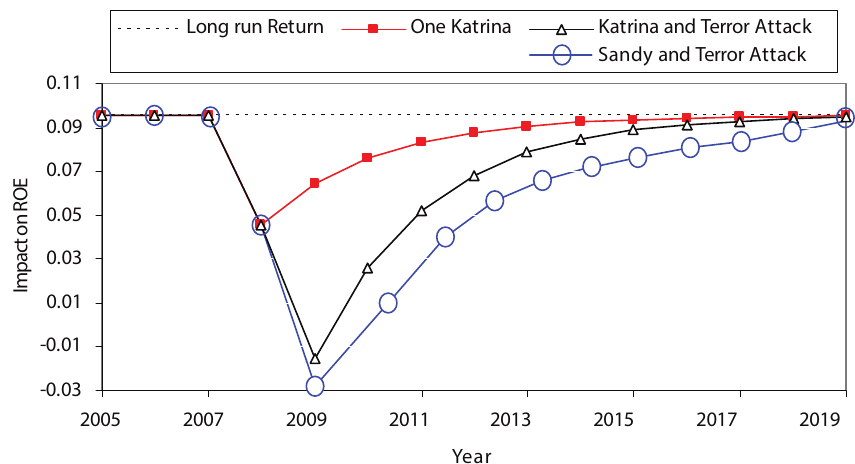
Figure 2. Response of return on equity to compound extreme event